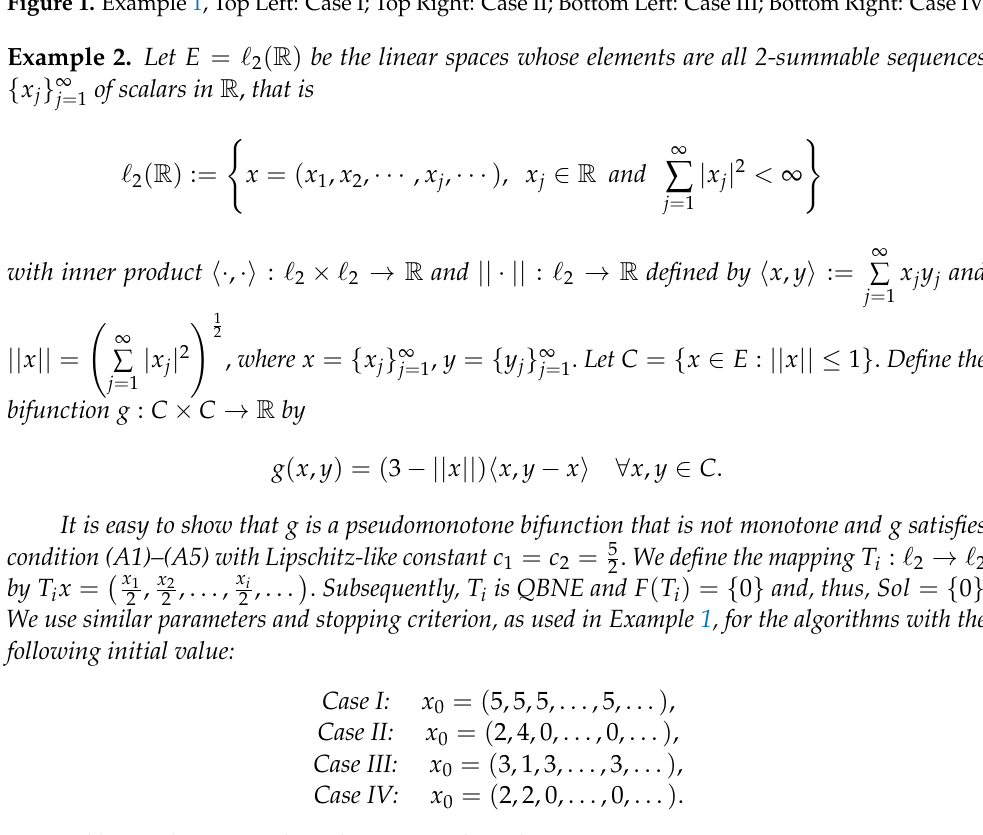
Figure 1. Example 1, Top Left: Case I; Top Right: Case II; Bottom Left: Case III; Bottom Right: Case